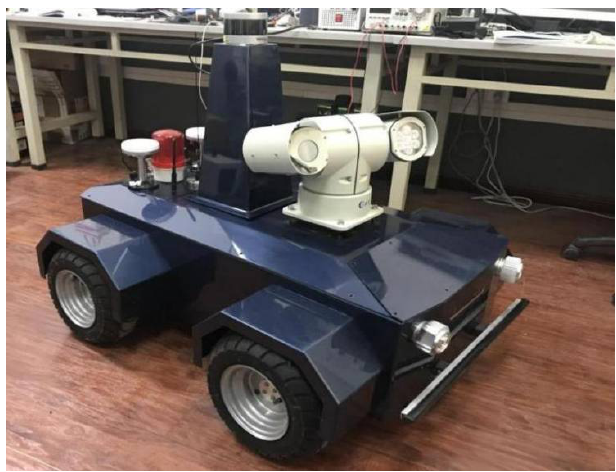
Figure 2. Wheeled inspection